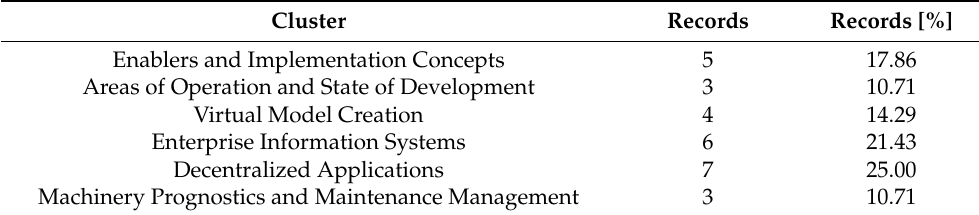
Table 8. Clusters according to the content of the